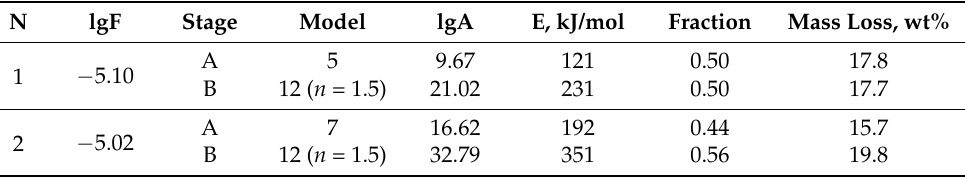
Table 4. Two chosen results for the modeling of the main peak of the DTG curve (region I) during the thermal decomposition of [Ni(En) 3 ](ClO 4 ) 2 in helium with β = 5 °C·min − 1 .